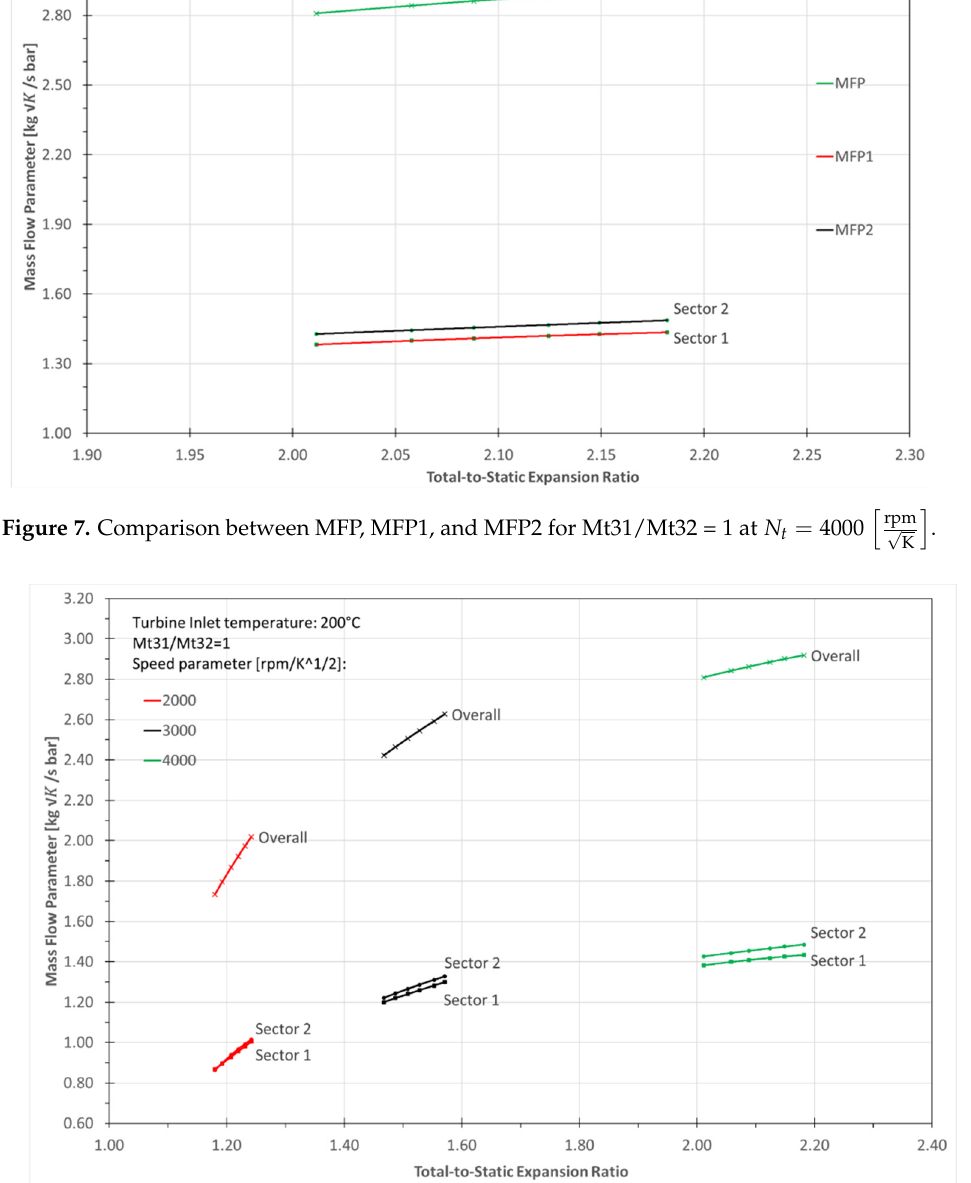
Figure 8. Effect of the rotational speed on the geometric asymmetry.